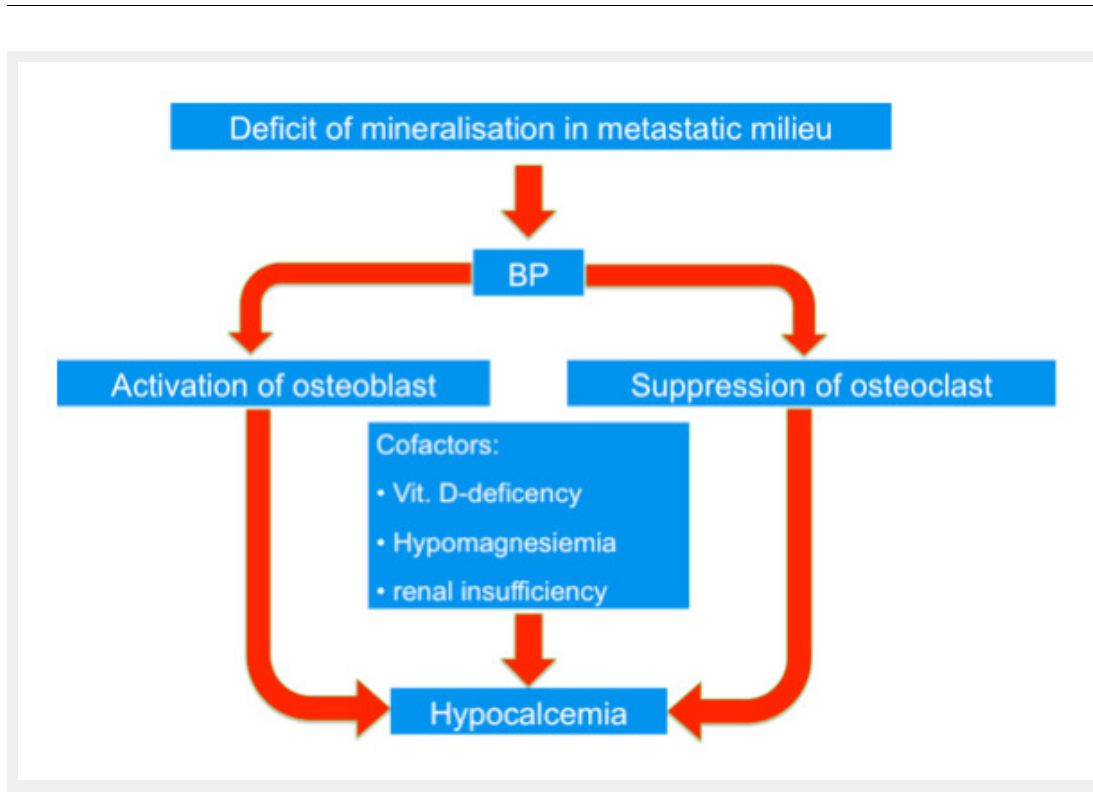
Figure 1 Increased deposition of calcium and phosphate in bone through osteoblastic metastases is postulated, which leads to decreased calcium and phosphate which stimulates PTH secretion and leads to secondary hyperparathyroidism. The application of bisphosphonates leads to further lowering of Ca and thus stimulates secondary